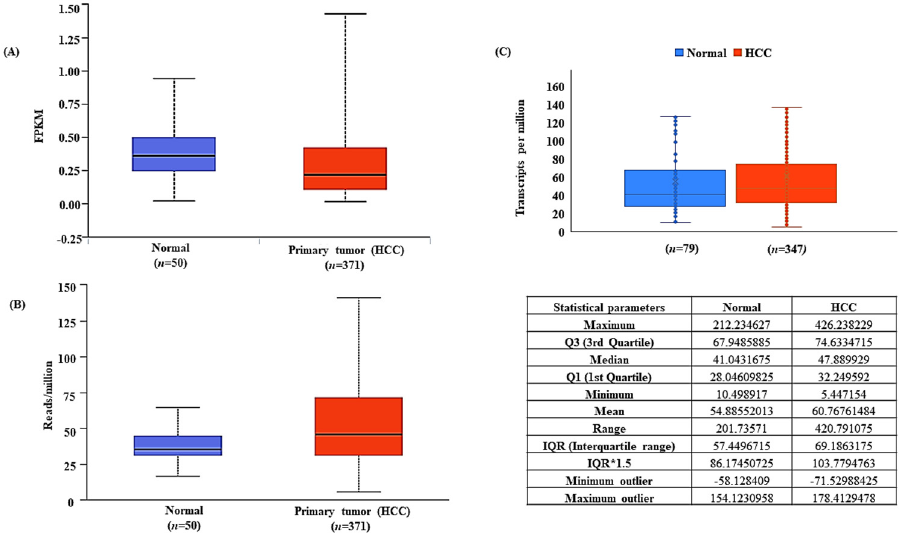
Figure 2. Differential expression of MEG3 and miR-664a-3p in TCGA-LIHC. ( A ) MEG3 is downregu- lated in HCC as compared to normal liver tissues in TCGA-LIHC. ( B ) miR-664a-3p is upregulated in HCC as compared to normal liver tissues in TCGA-LIHC. ( C ) Validation of transcriptome profile of miR-664a-3p in HCC (statistical parameters included).